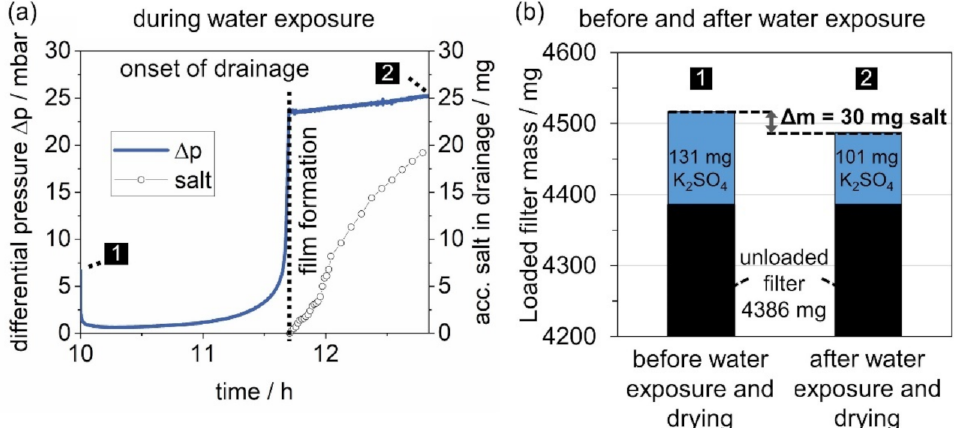
Figure 11. ( a ) Differential pressure of the salt-laden filter during exposure to water mist with the ac-cumulated mass of salt detected in the drainage in relation to ( b ) the gravimetrical analysis of the